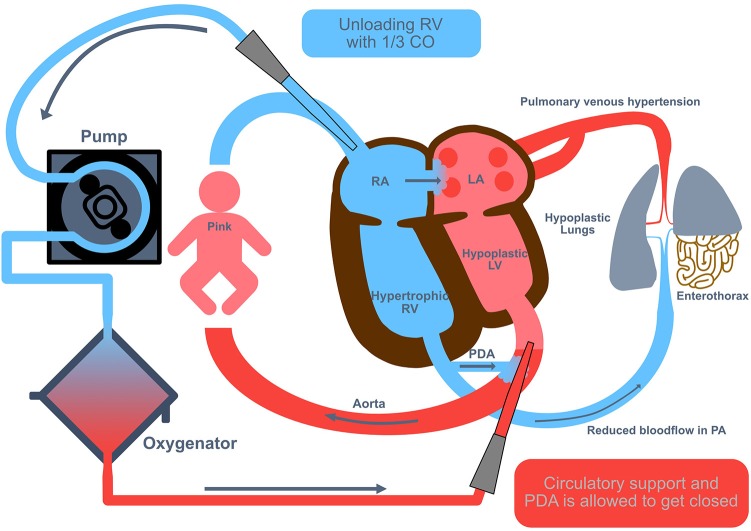
Veno-arterial extracorporeal membrane oxygenation in congenital diaphragmatic hernia (CDH). Veno-arterial (VA) extracorporeal membrane oxygenation (ECMO) is usually performed with an open cut-down technique where the right common carotid artery and right internal jugular vein are isolated and cannulated. Circuit flows are gradually increased to provide about 50 to 100 mL/kg/min, equivalent to an unloading of the right ventricle with 1/3 of the cardiac output. CO, cardiac output; LA, left atrium; LV, left ventricle; PA, pulmonary artery; PDA, persistent ductus arteriosus; RA, right atrium; RV, right ventricle.